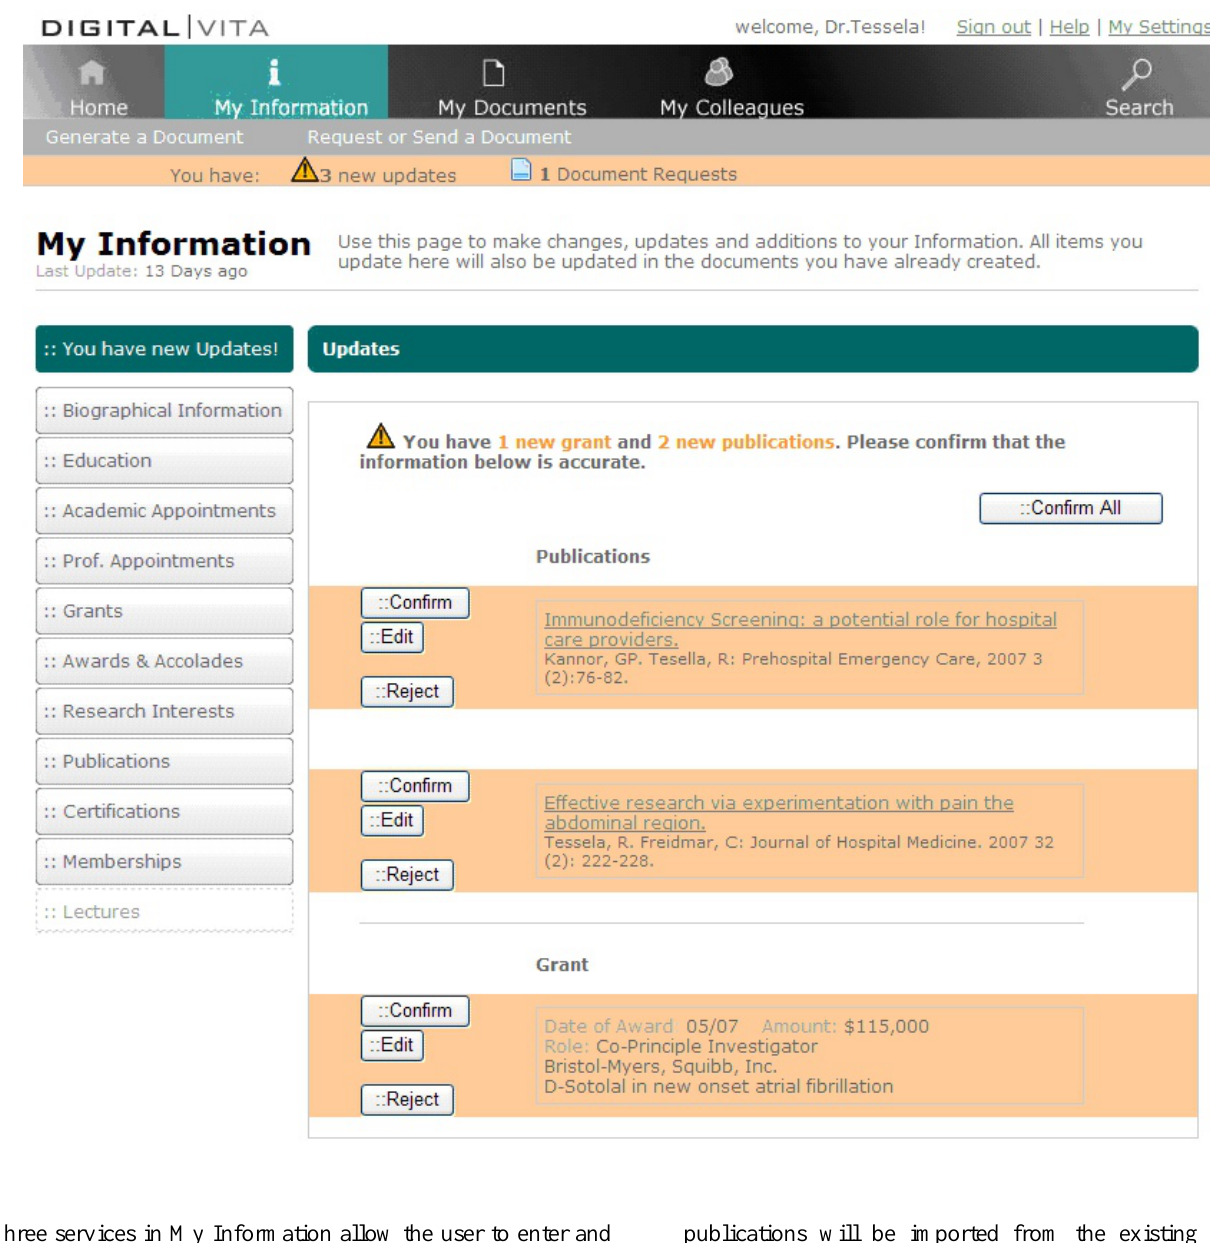
Figure 2. The My Information component in Digital|Vita allows the user to enter and update biographical information through manual or semiautomated